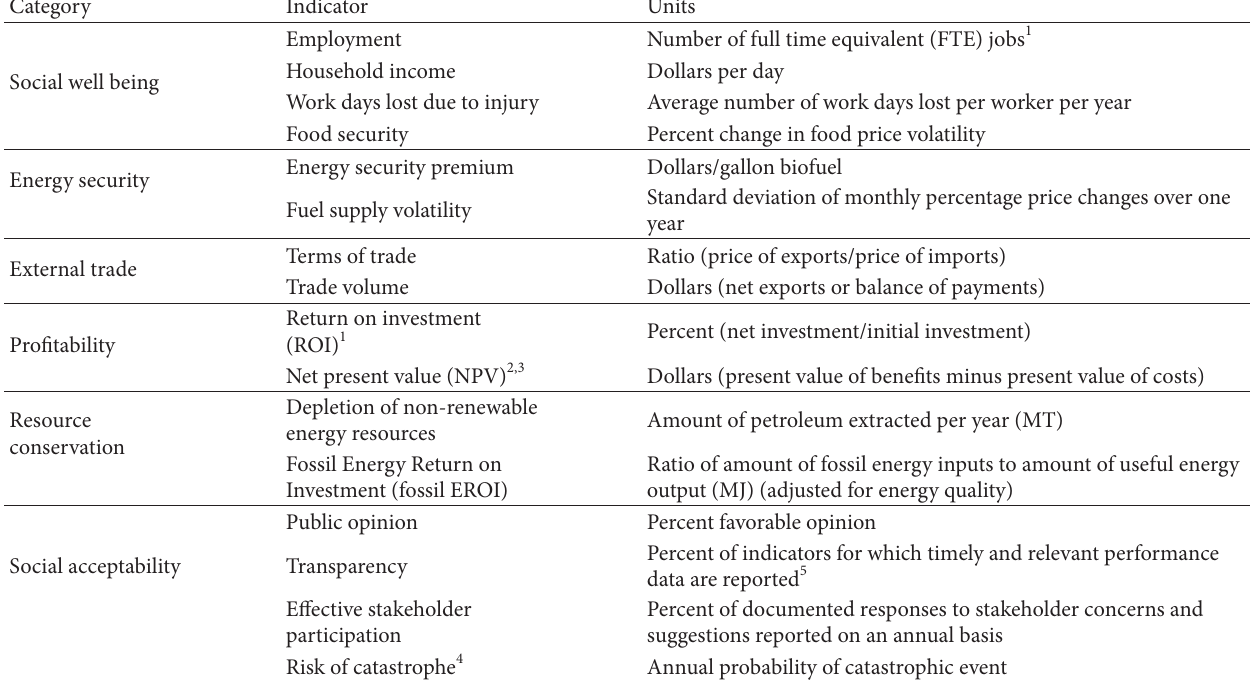
T 3: List of recommended socioeconomic indicators for bioenergy sustainability (derived from Dale et al. (2013) [5]). Category Indicator Social well